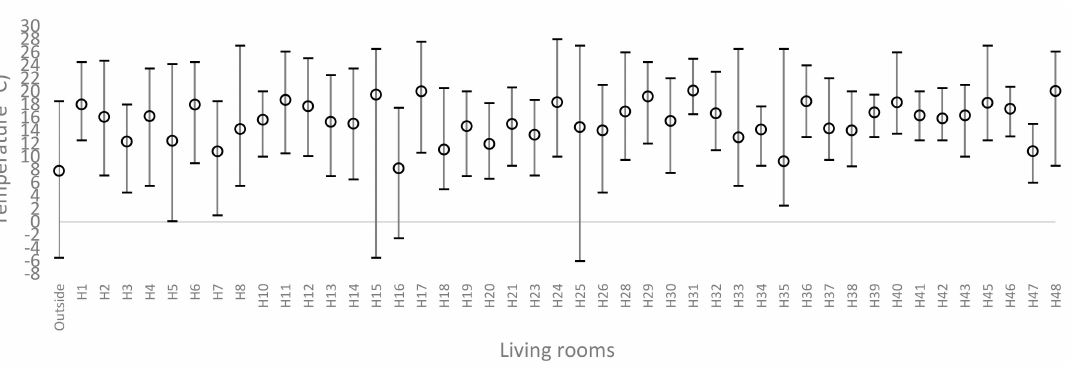
Figure 2. Minimum, maximum, and mean temperatures in living rooms of each monitored dwelling during the